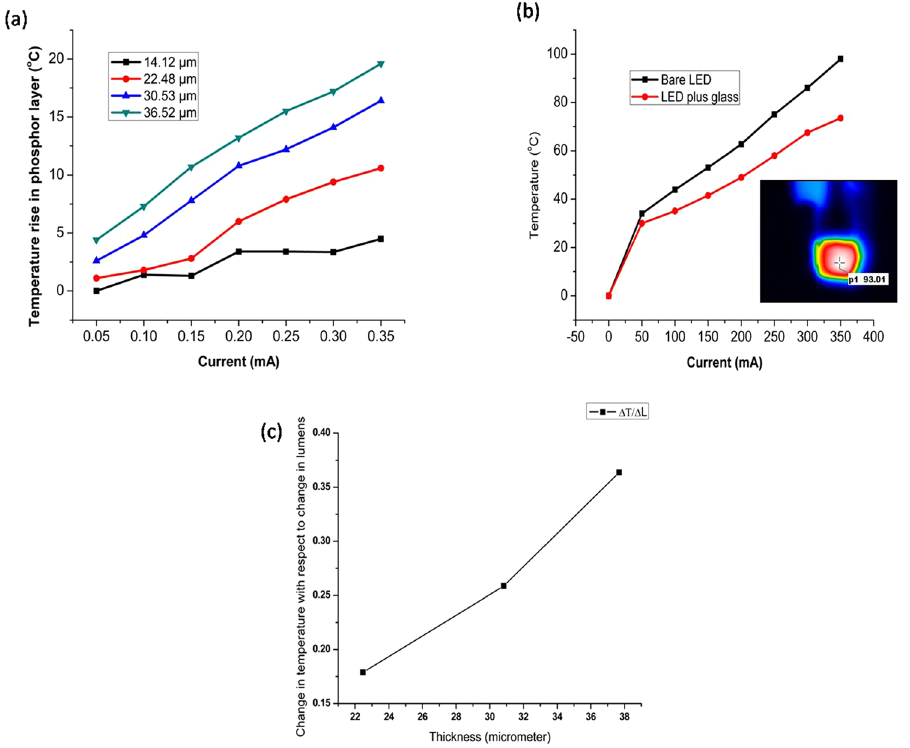
Figure 14. ( a ) Temperature rises in the phosphor layers of different thicknesses (the temperature change in the bare glass substrate is subtracted from the temperature of the samples with varying phosphor thickness). ( b ) Temperature rise in the bare LED and LED plus glass (no phosphor structure) vs current measured. Inset shows the thermal image taken for one of the samples. ( c ) Change in temperature per unit change in lumen for phosphor layers with different thickness at 250 mA driving